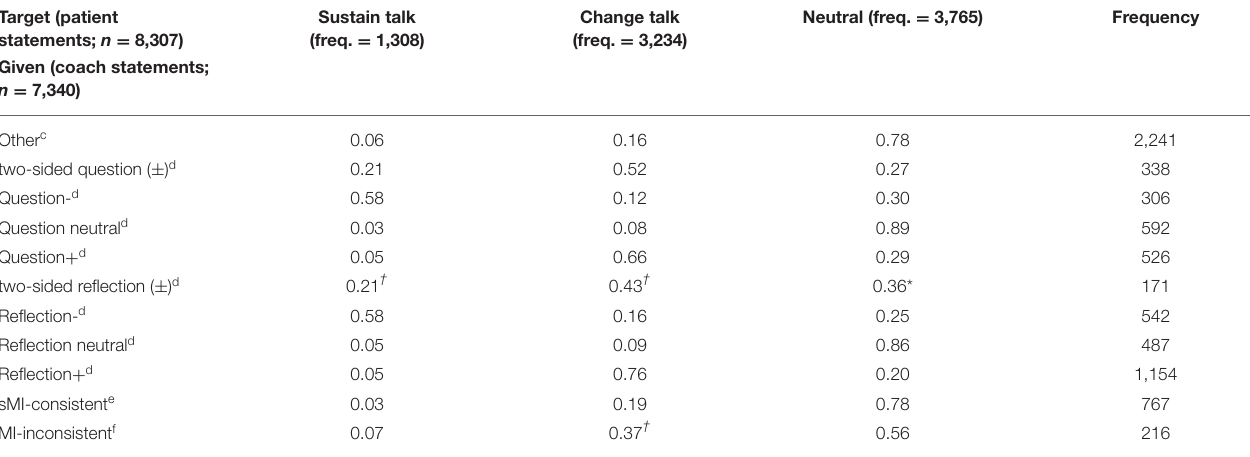
TABLE 8 | Transition probabilities ab of patient statements following a coach